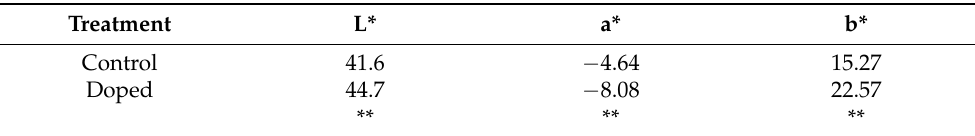
Table 2. Leaf colour parameters of the lettuce leaves. Lightness (L*) ranges from 0 (black, no reflection) to 100 (white, perfect diffuse reflection); a* ranges from green (–60) to red (+60); b* ranges from blue ( − 60) to yellow (+60). Treatment L* a* b* Control